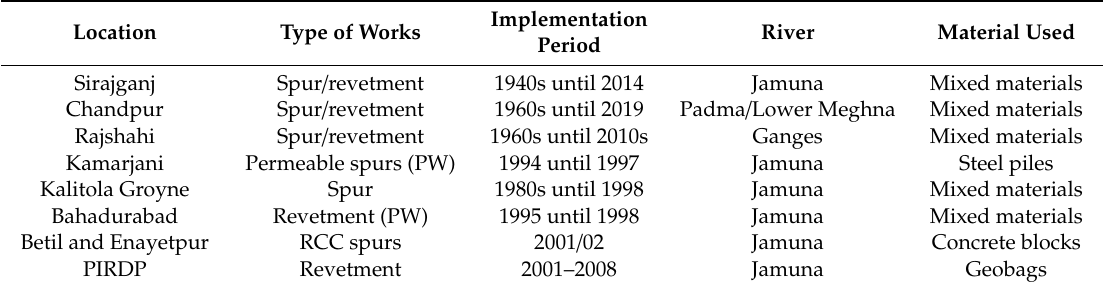
Table 2. Summary of major riverbank protection schemes (PW = pilot works). Location Type of